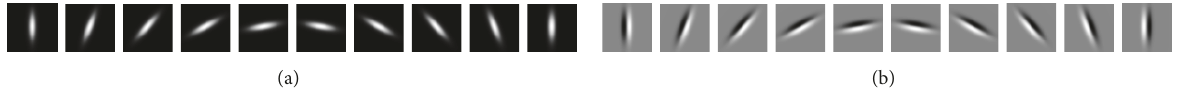
Figure 4: AnisotropicGKFs with theircorresponding OAGDFs 𝜎 2 = 9 , 𝜌 2 = 4 , 𝜃 = 𝑘𝜋/10 ,and 𝑘 = 0, 1,2, .. ., 9 .(a) AGKFs and (b)OAGDFs.